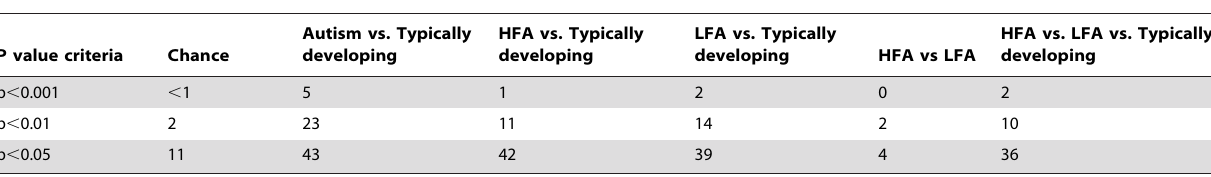
Table 3. Significant measures for study comparisons - counts only.